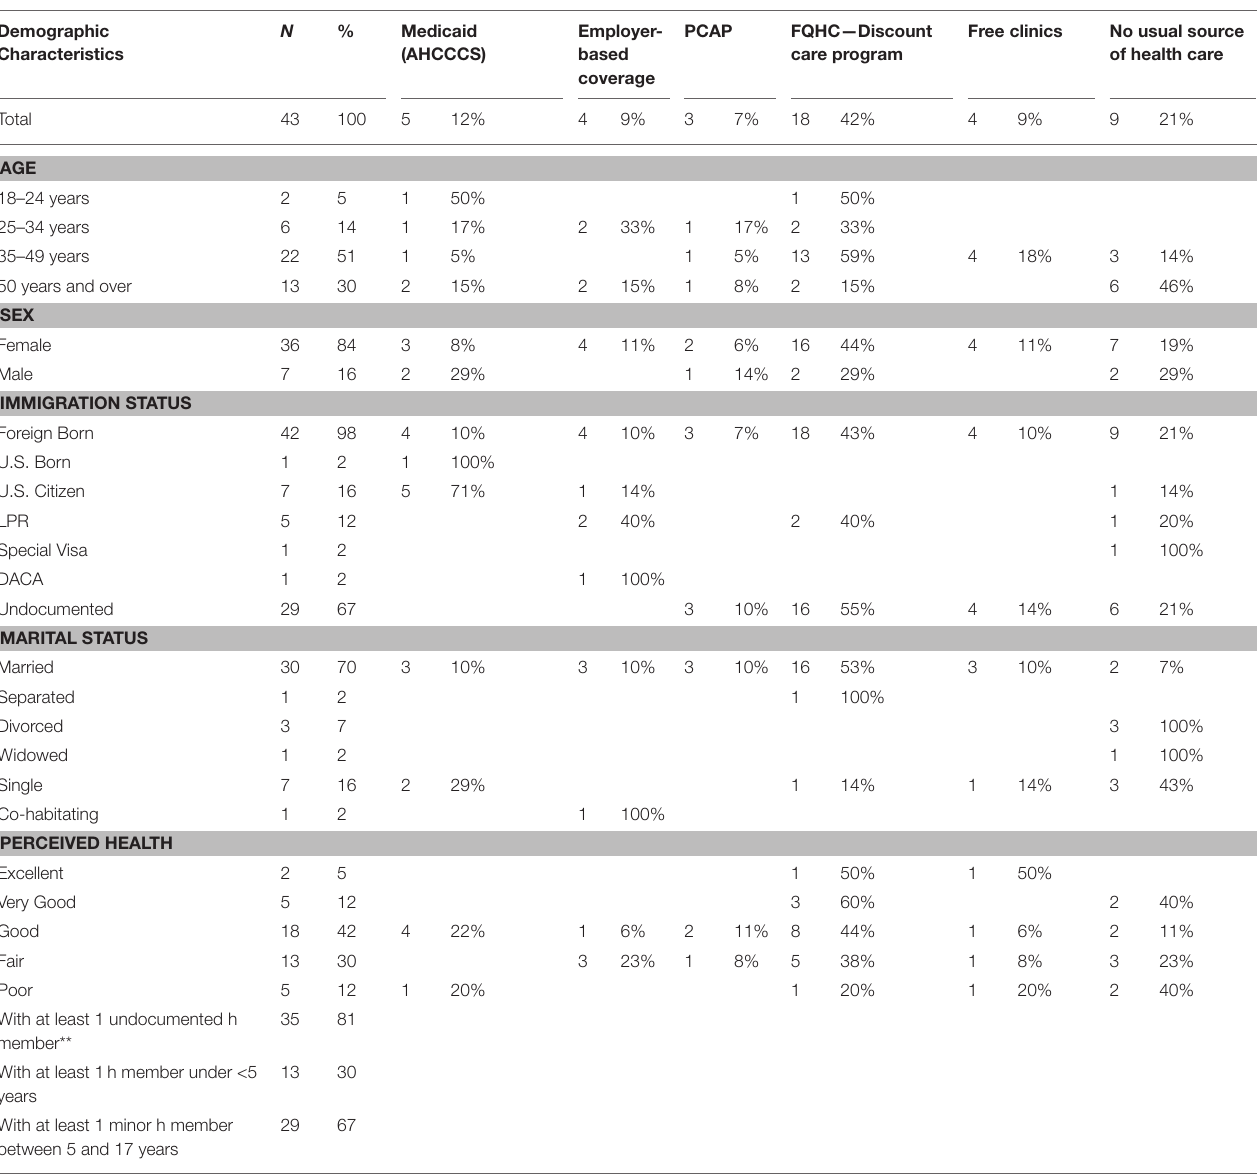
TABLE 1 | Interviewee’s usual source of health care a and selected demographic ( N = 43). Demographic Characteristics